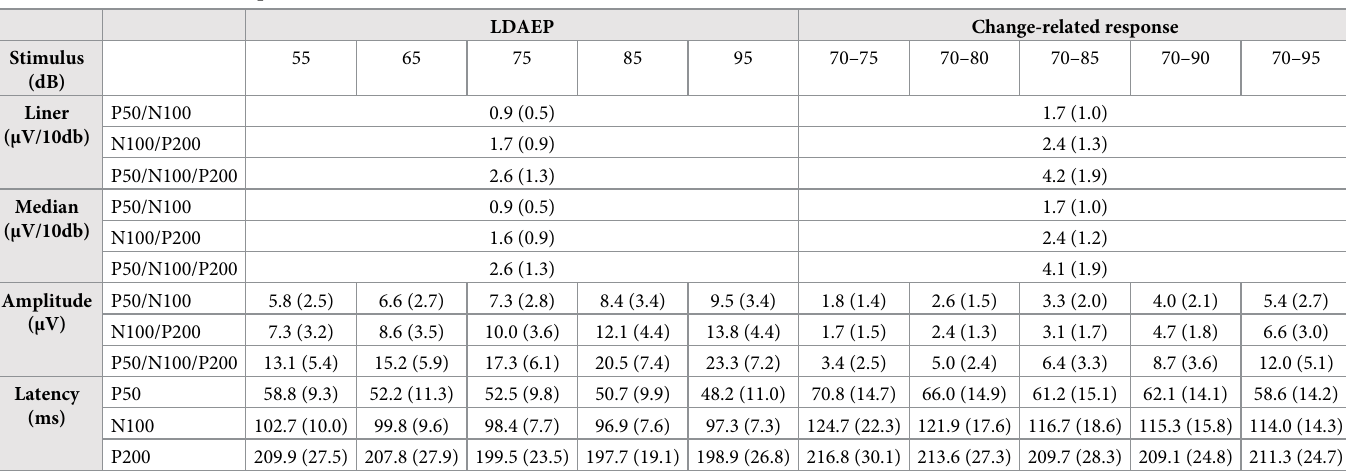
Table 1. Linear and median slopes. Values are shown as the mean (SD).